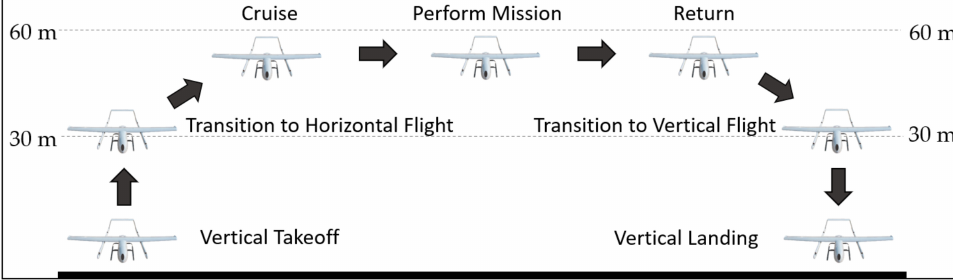
Figure 2. Idealized VTOL turboeletric mission